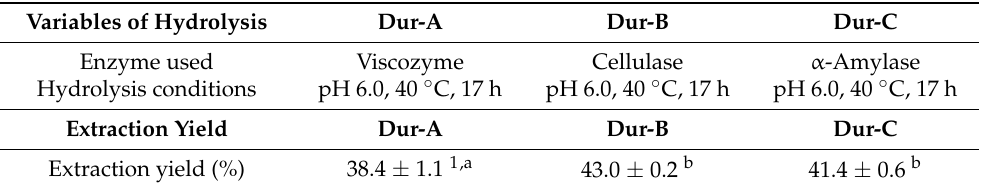
Table 1. Hydrolysis variables and extraction yields of enzymatic hydrolysis products (Dur-A, Dur-B, and Dur-C) from D. antarctica .